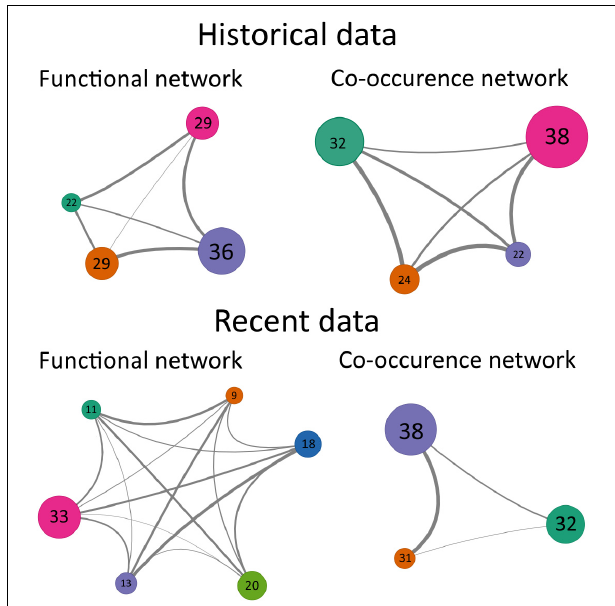
FIGURE 5 | Schematic representation of networks obtained for benthic communities in 1990 (historical data) and 2014 (recent data). The numbers inside the circles correspond to the number of taxa composing each node and the width of edges is proportional to the adjacency between the nodes. The networks obtained from the trait data (functional networks) are on the left side and the network obtained from the taxa abundance data (co-occurrence networks) are on the right side.